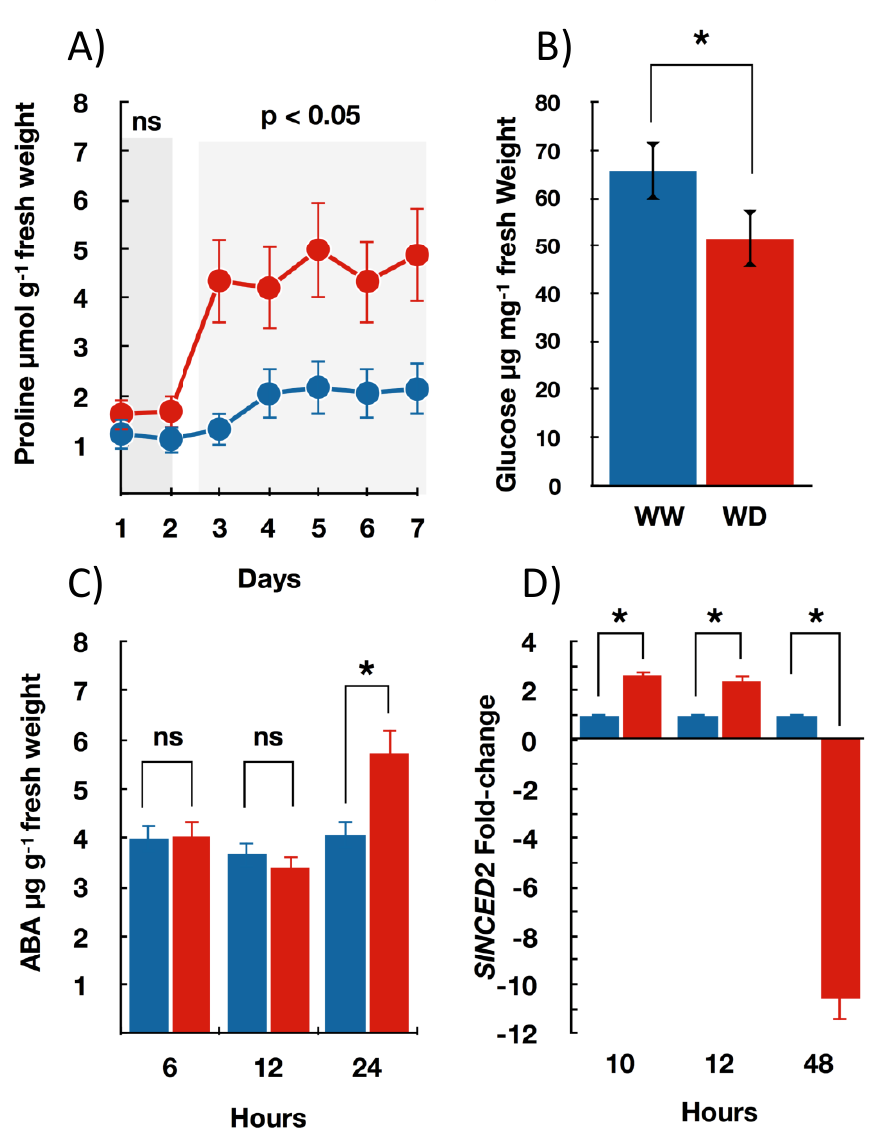
Figure 6. Daily ( A ) Proline concentration and ( B ) total carbohydrate concentration in seedlings after 7 growth days. ( C ) ABA accumulation and ( D ) SINCED2 expression. Blue represents well-watered seedlings; red represents water-deficit treated seedlings. * means p value < 0.05. ns, not significant.